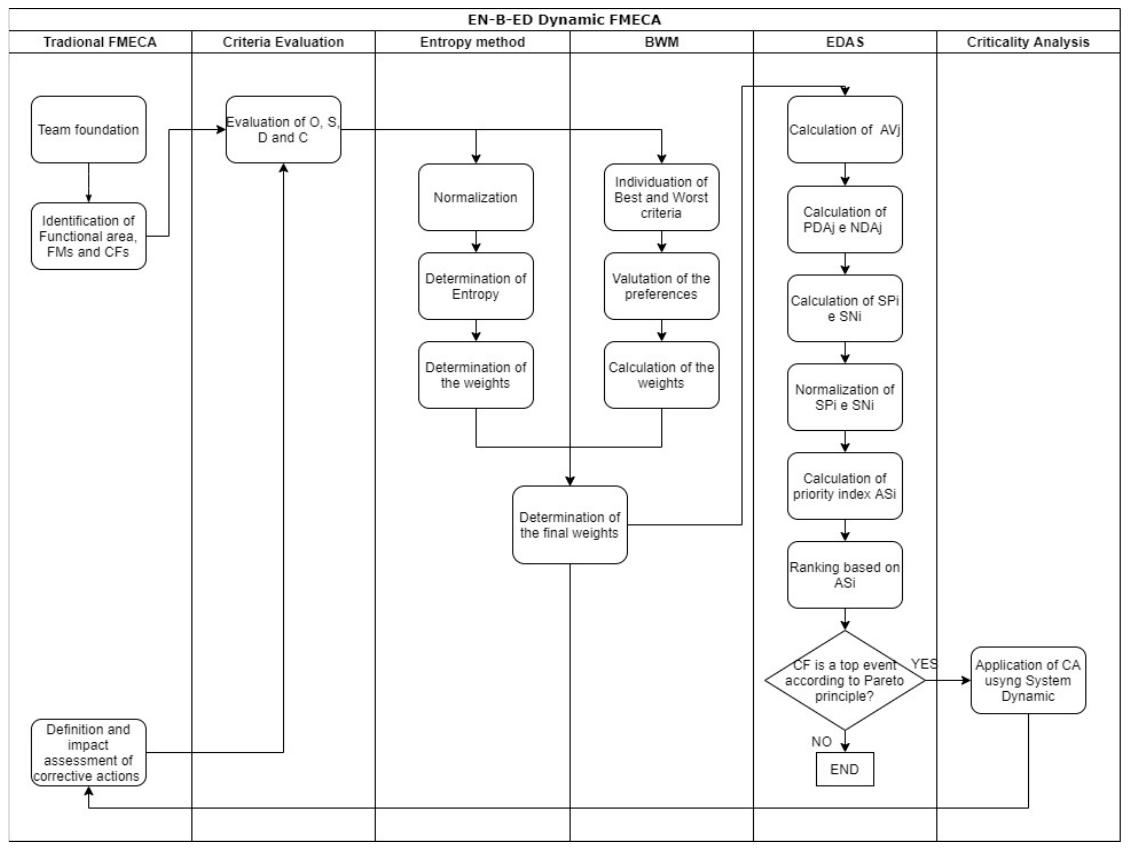
Figure 1. Flowchart of the Entropy Best Evaluation Distance Dynamic FMECA (EN-B-ED Dynamic FMECA) methodology.